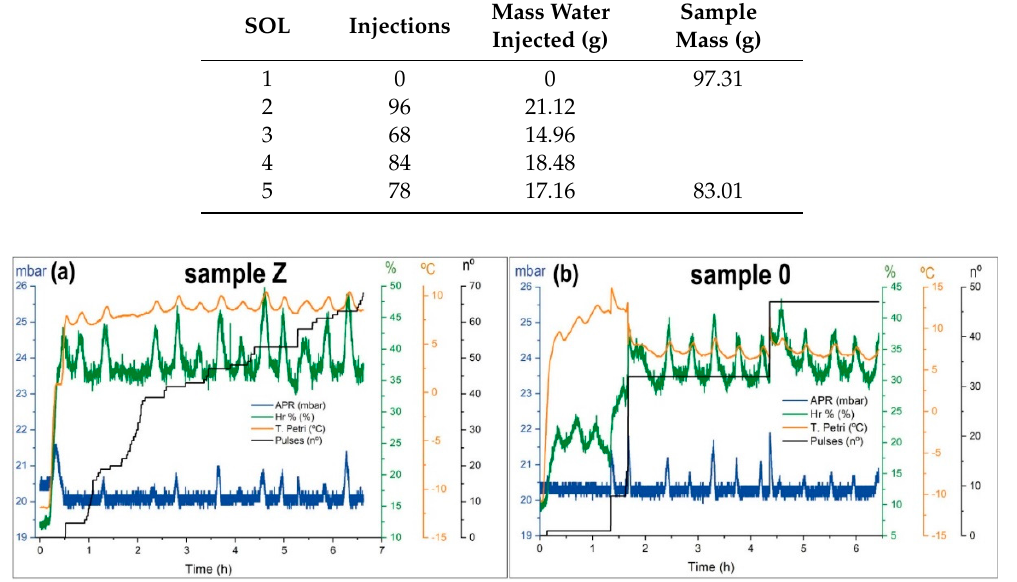
Figure 11. Environmental variables during the third SOL. Pressure (mbar) is in blue, relative humidity (%) in green, the sample temperature (°C) in orange. The number of pulses injected in black. ( a ) Sample Z. ( b ) sample 0. Z. ( b ) sample